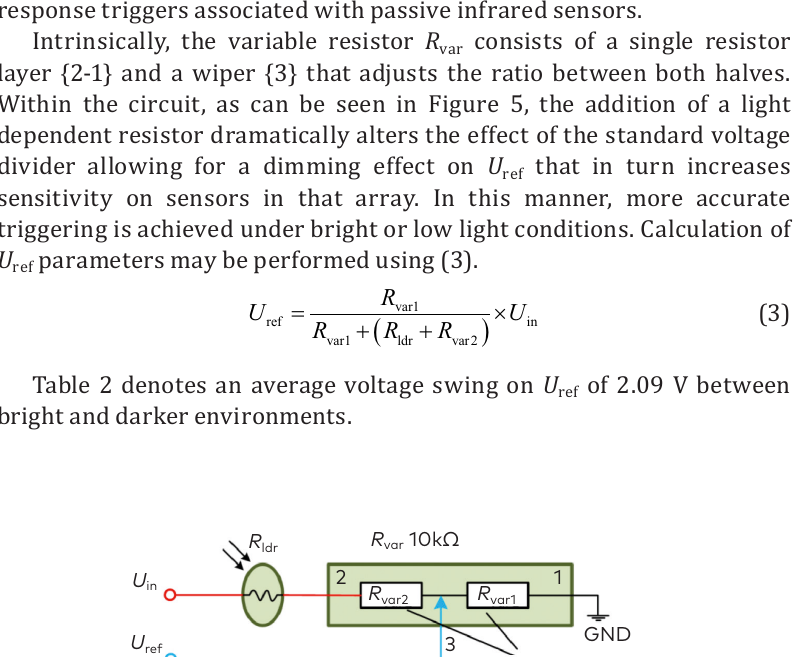
Figure 5. LDR /VAR potential divider configuration for ambience